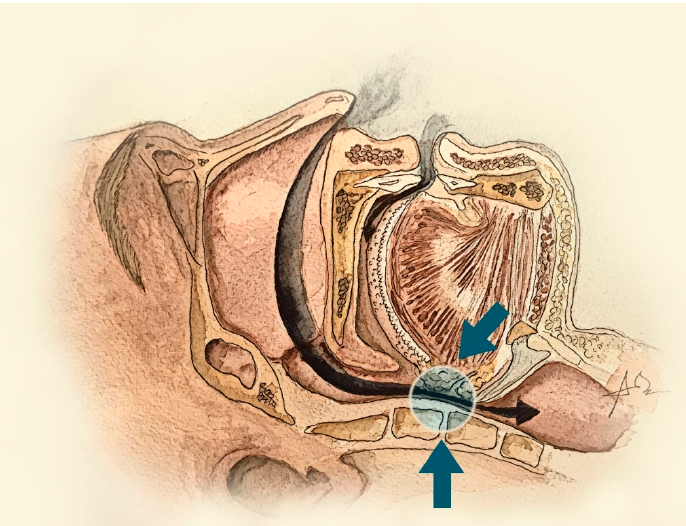
Figure 4. Representation of upper airway collapsibility in patients with OSA. The transition from wake to sleep decreases GG activity and increases upper airway